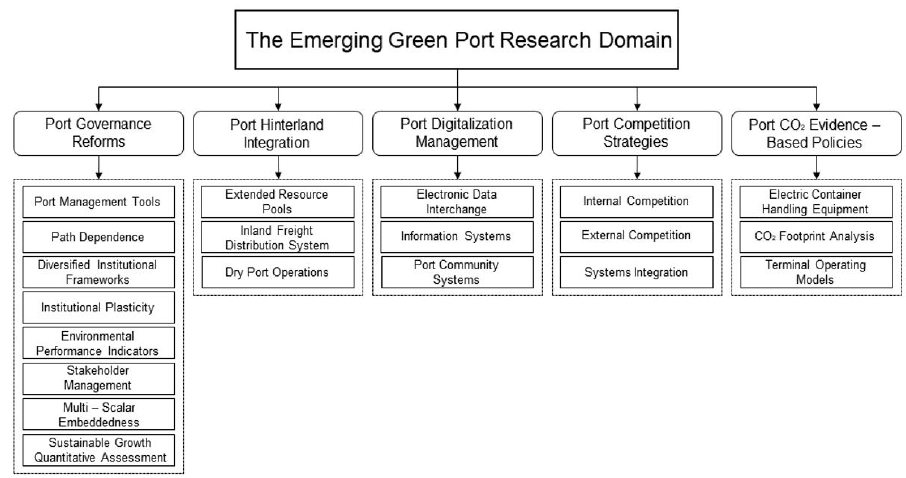
Figure 6. The schematic view of the five concurrent research streams with their respective sub-streams that constitute the emerging green port research domain.